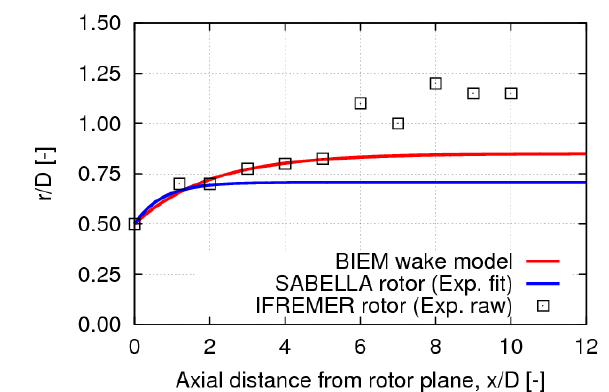
Figure 2. Streamtube radius downstream of rotor plane from Equation (9) and comparative data from